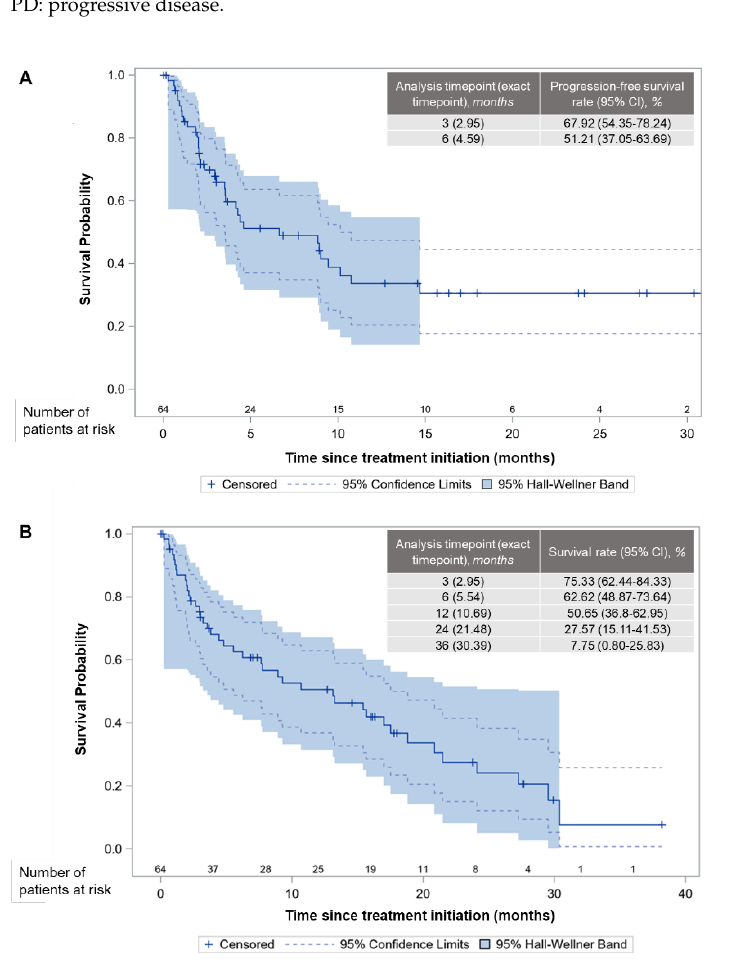
Figure 1. Kaplan–Meier curves and landmark time analysis in the full analysis set. ( A ) progression- Figure 1. Kaplan – Meier curves and landmark time analysis in the full analysis set. ( A ) progres- free survival. ( B ) overall sion-free survival. ( B ) overall survival. Table 2. Progression-free survival analysis.